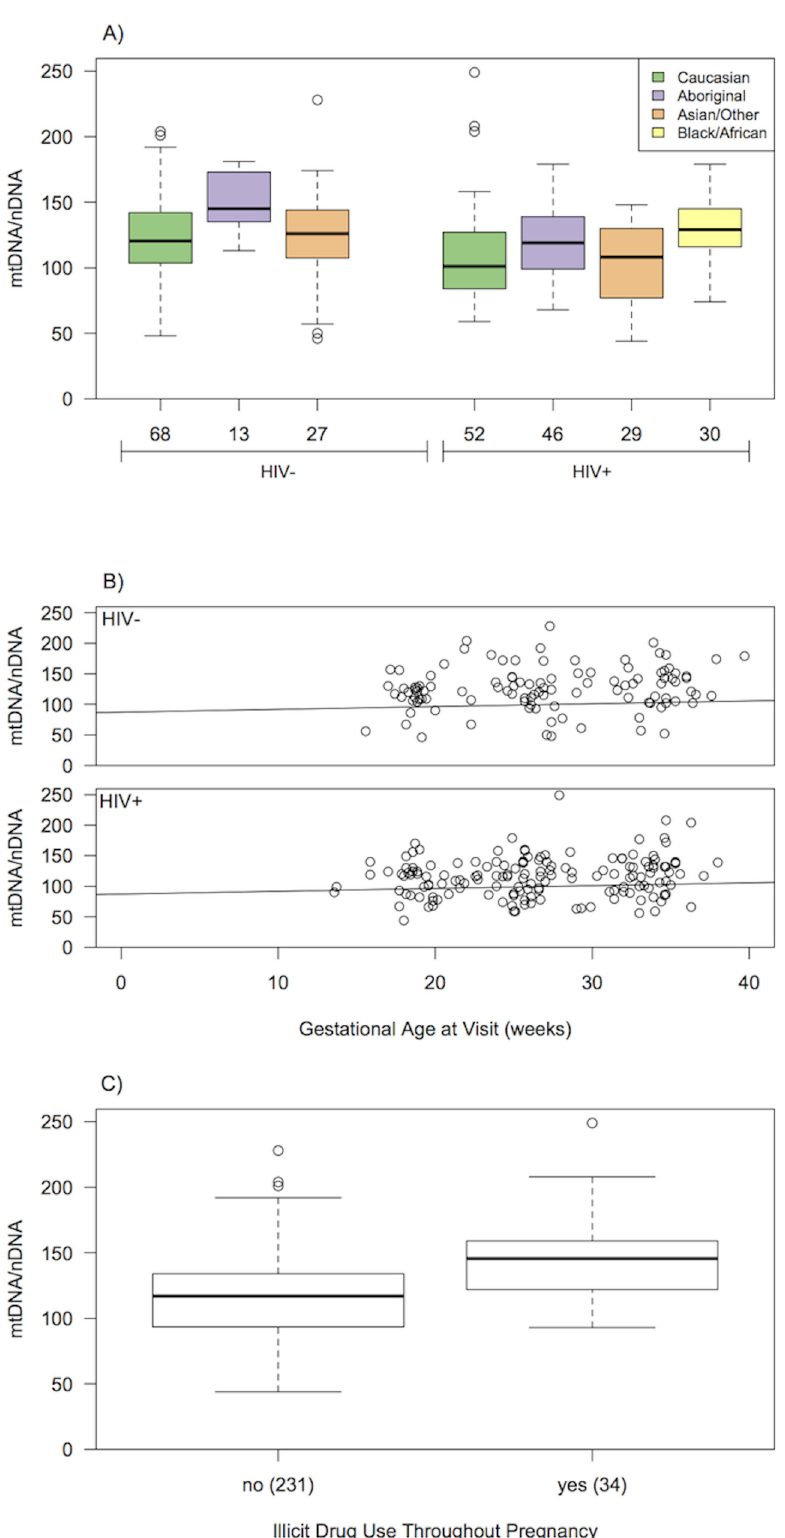
Fig 1. Significant associations between mtDNA/nDNA ratio and variables of interest for both HIV- and HIV+ cohorts ( N = 105). (A) Ethnicity, (B) GA at visit (weeks) and (C) Illicit drug use. In A and C, the